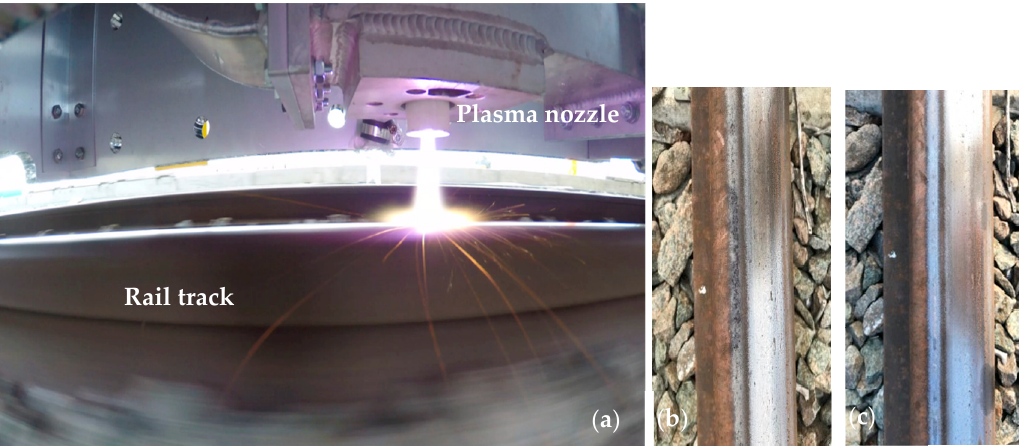
Figure 10. Photographs taken with a Go-Pro camera during on-track testing. ( a ) plasma ON; ( b ) and ( c ) rail track showing the cleaning effect of plasma (removal of rust and other debris).